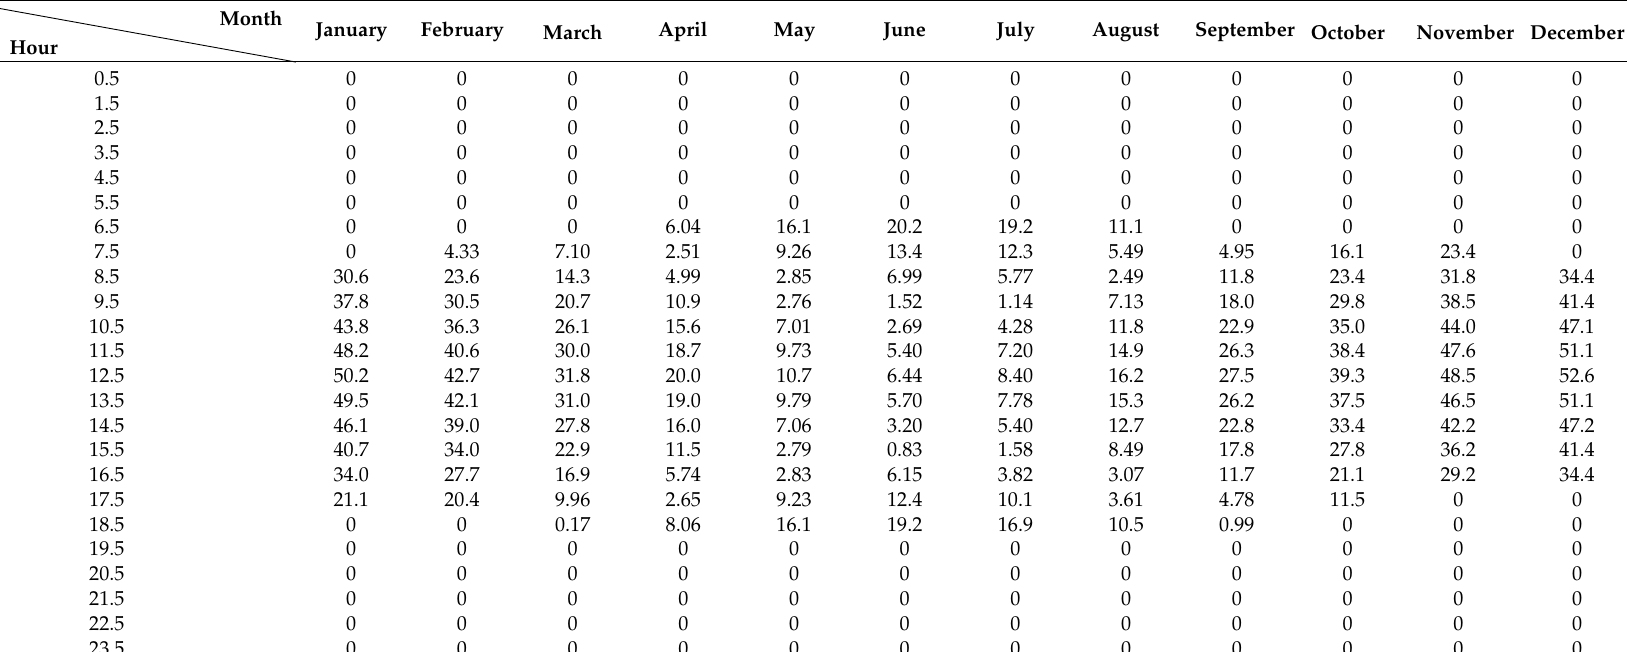
Table A4. Average hourly solar incidence angle